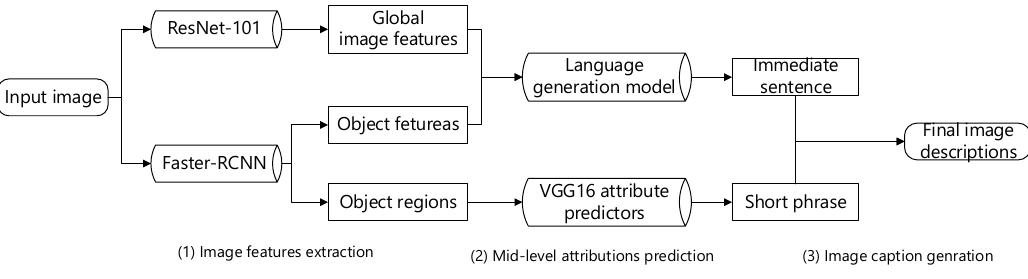
Figure 1. The framework of our proposed middle-level attribute-based language retouching